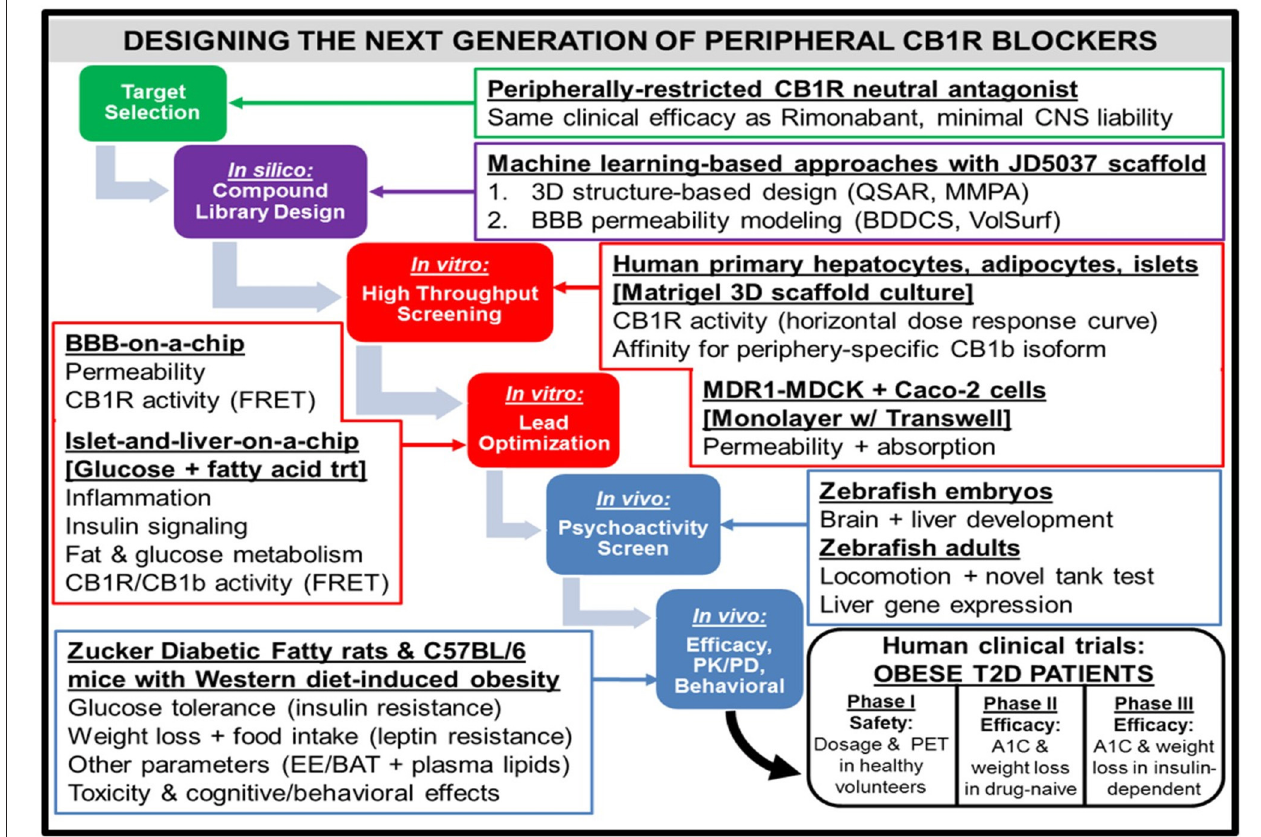
FIGURE 4 | Workflow for the design of a hypothetical “next-generation” peripheral CB1R blocker. At all phases of the design process, efficacy (i.e., metabolic effects on peripheral organs) as well as safety [i.e., impermeability to blood-brain barrier (BBB)] will receive equal emphasis. Computerized techniques such as quantitative